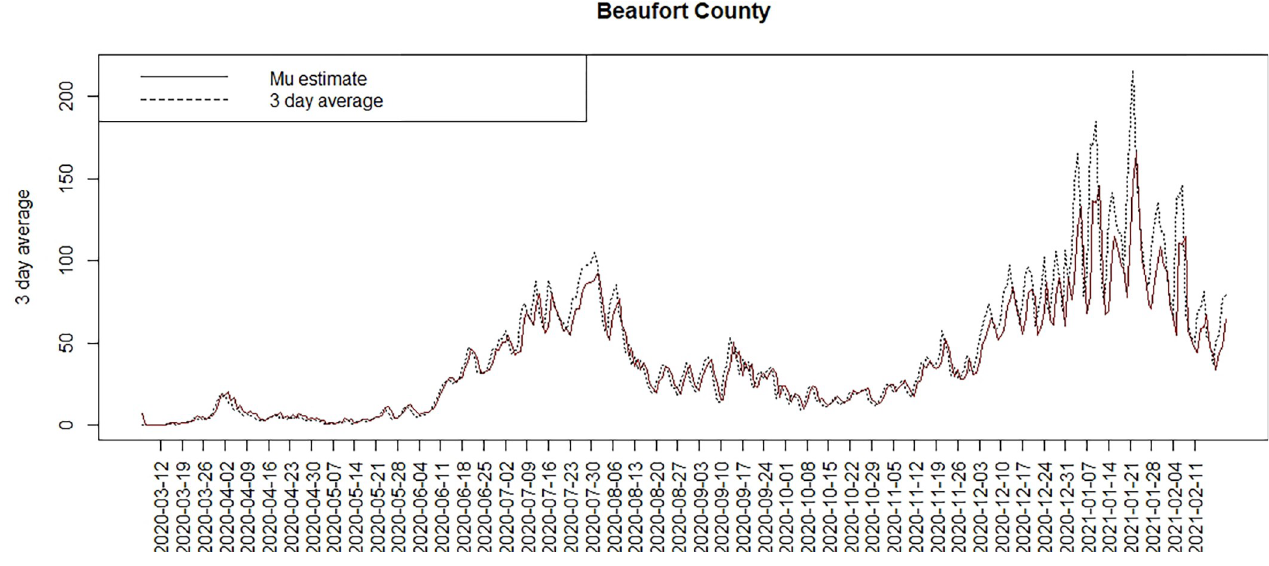
Fig 7. Count and posterior mean risk for Beaufort county under model 6.